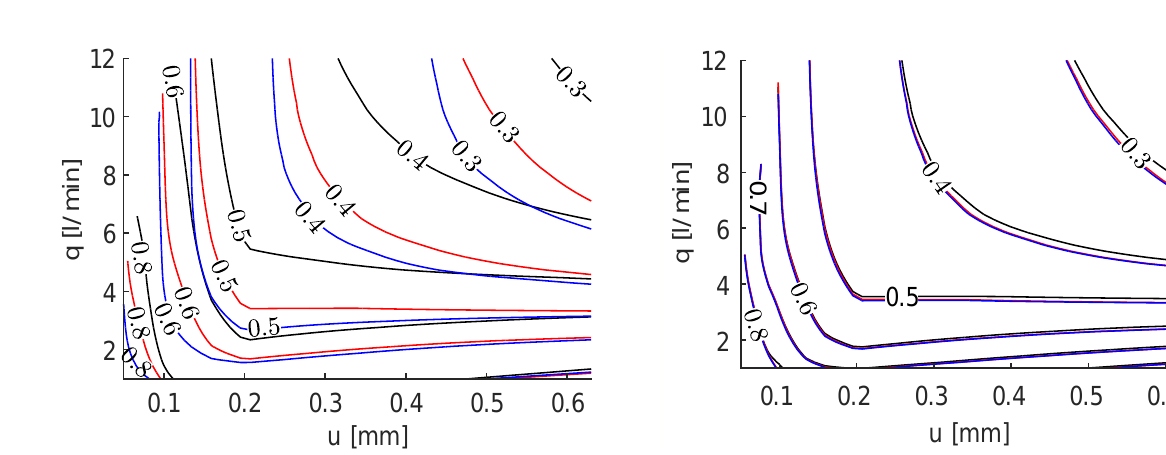
HEES+(blue) at 40 ◦